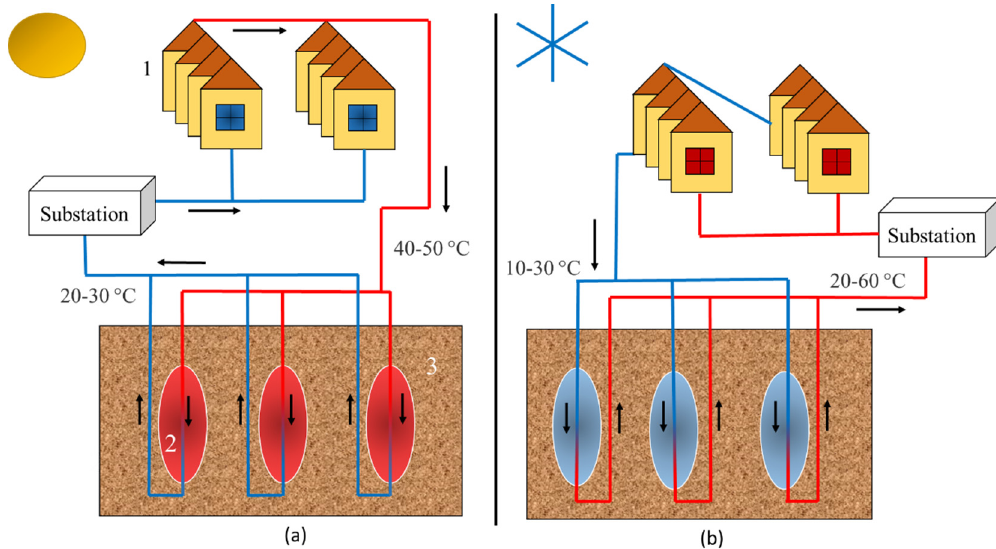
Figure 14. Borehole thermal storage in summer ( a ) and winter ( b ). 1—DH users, 2—borehole, 3—soil underground.